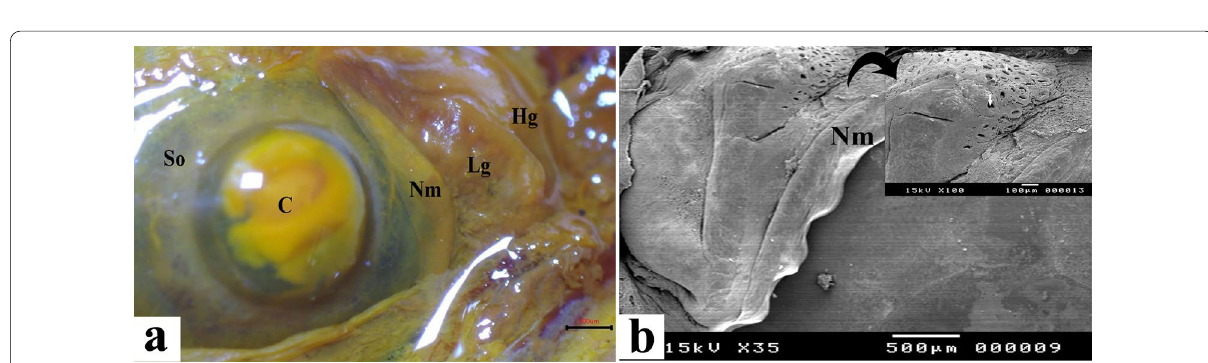
Fig. 6 A photomacrograph of the lacrimal gland of Egyptian agama, Trapelus mutabilis , showing a the position of the lacrimal gland (Lg) at nictitating membrane’s base (Nm), Harderian gland (Hg), Cornea (C) and Sclera ossicle (So). b Scanning electron micrograph of the lacrimal gland of Egyptian agama, Trapelus mutabilis , showing numerous orifices of the lacrimal gland